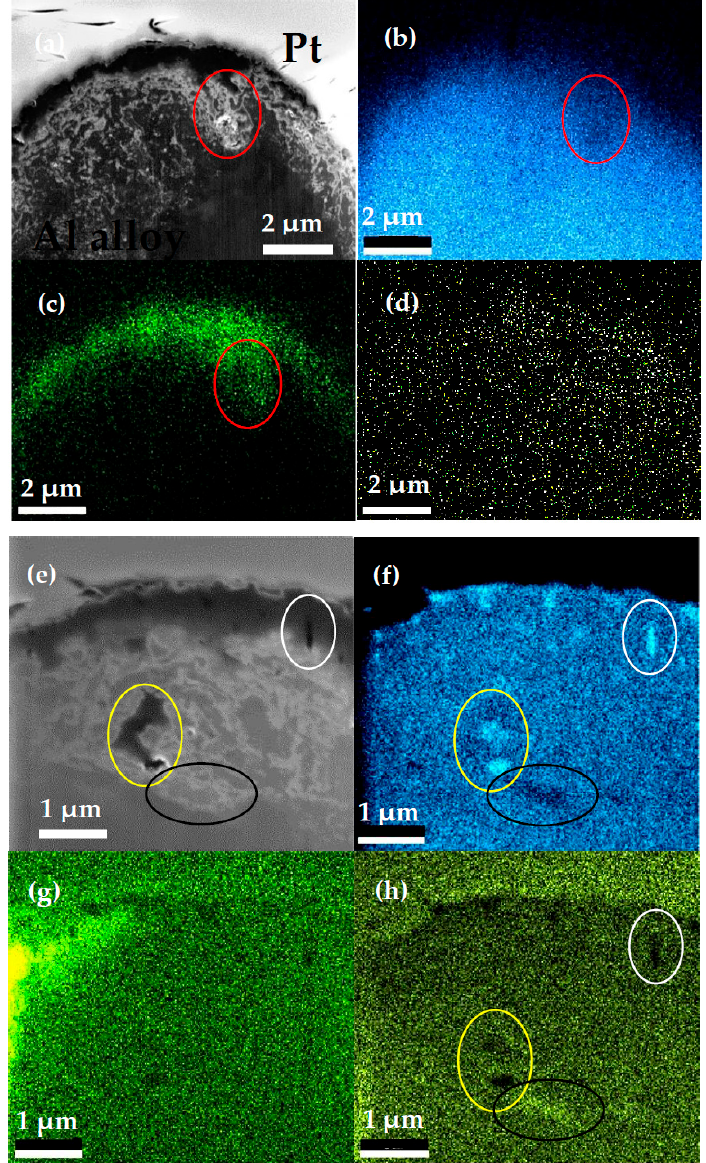
Figure 10. FIB sectioning of a cone formed by laser ablation treatment at 33 J/cm 2 with five scan repetitions: ( a ) SEM image of FIB-cut conical structure; ( b ) EDX showing Al concentration inside the FIB-cut conical structure; ( c ) EDX showing O concentration inside the FIB-cut conical structure; ( d ) EDX showing Cu concentration inside the FIB-cut conical structure; ( e ) SEM image of lamella cut from the conical structure; ( f ) EDX showing Al concentration inside the lamella cut from the conical structure; ( g ) EDX showing O concentration inside the lamella cut from the conical structure; ( h ) EDX showing Cu concentration inside the lamella cut from the conical structure. Contrast is enhanced for all images.